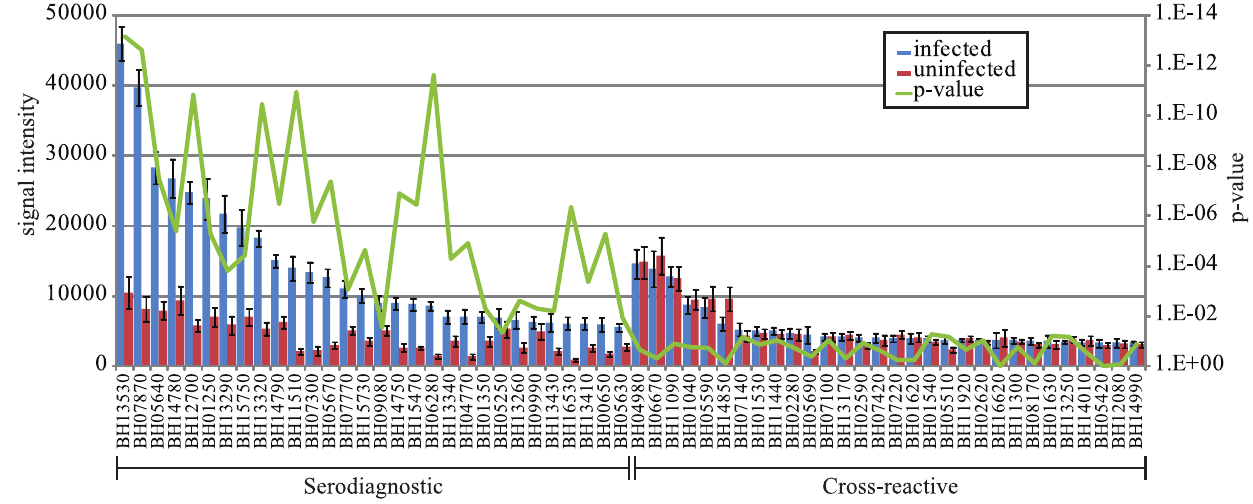
Figure 3. Discovery of cat serodiagnostic antigens. The 30 most reactive serodiagnostic and differentially reactive antigens are plotted on the x-axis. The mean seroreactivity of each antigen was compared between the infected (n=62) and uninfected (n=62) groups plotted in blue and red, respectively, with SEM. Corresponding p-values for each antigen are shown as a green line on the secondary y-axis.